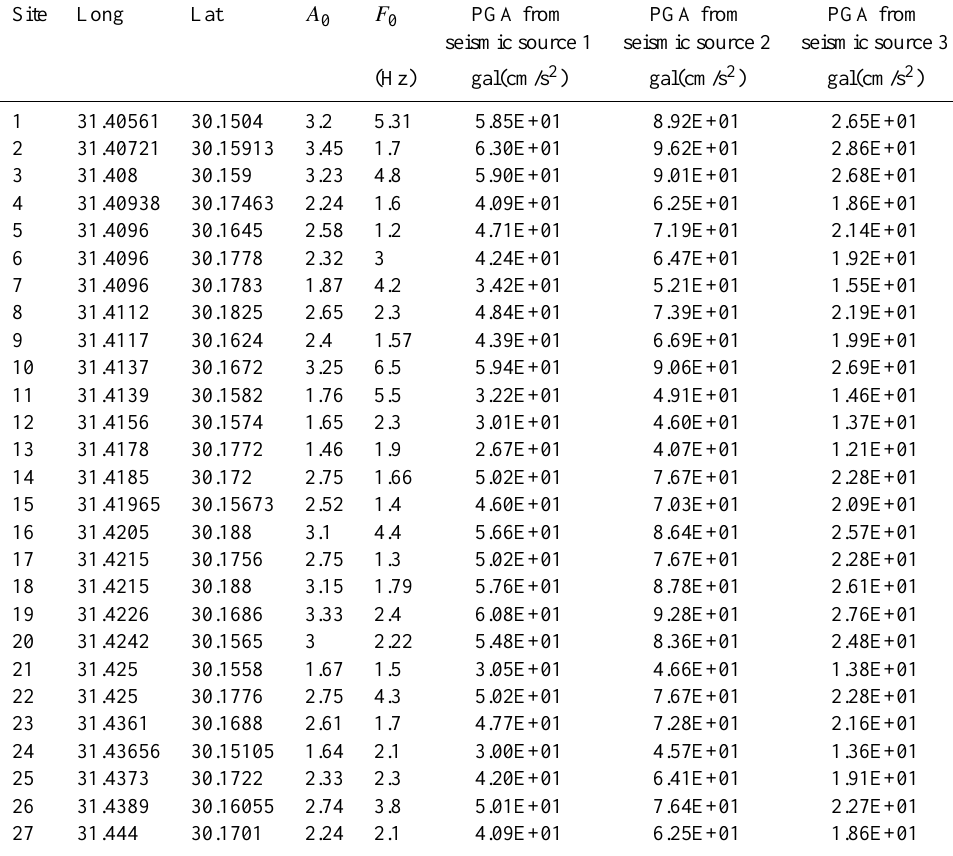
Table 4. The estimated A0 and F0 and the PGA predicted from the effective seismogenic zones at the investigated sites in the area of interest.